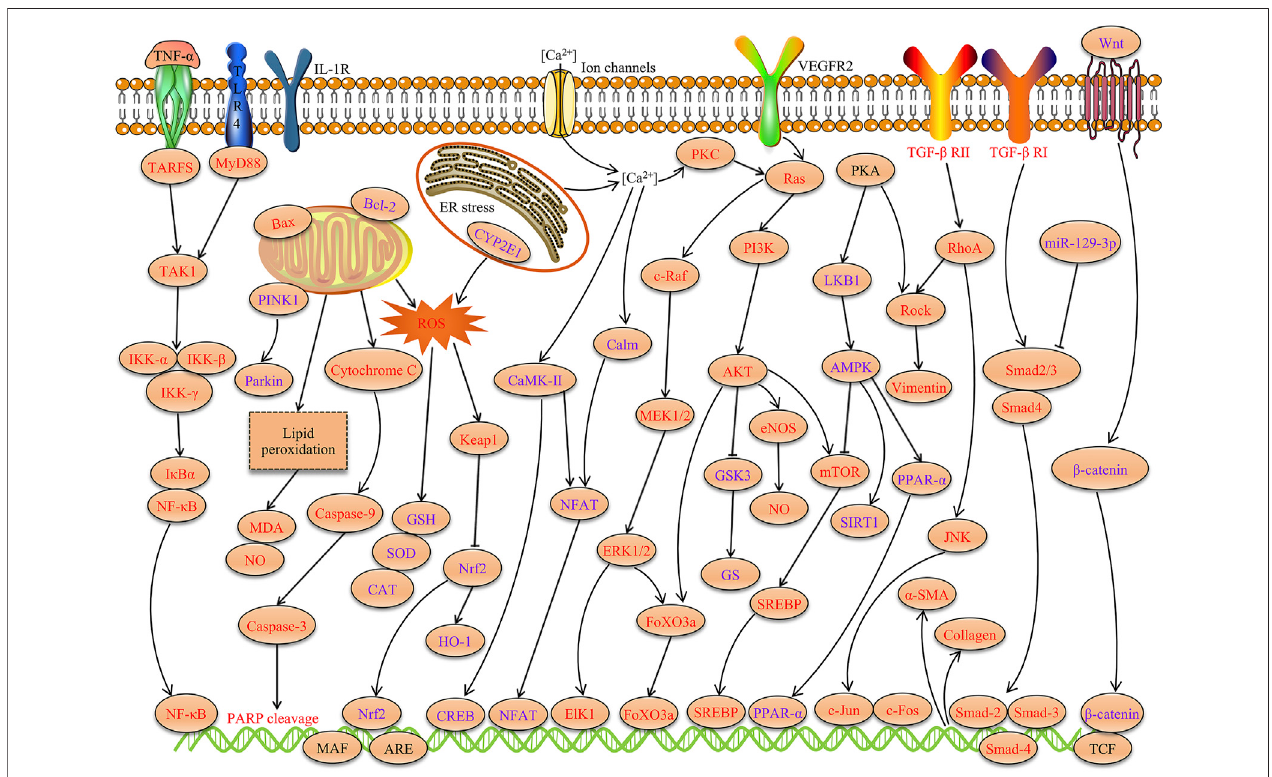
FIGURE 3 | Molecular pathways involved in the pharmacological properties of TSG. TSG exerts signi fi cant anti-in fl ammation, antioxidant, neuroprotection, cardiovascular protection, hepatoprotection, anti-osteoporosis, enhancement of memory and anti-aging activities through modulating these signaling transduction pathways (Red represents the inhibitory effect of TSG and purple represents the promotion effect of